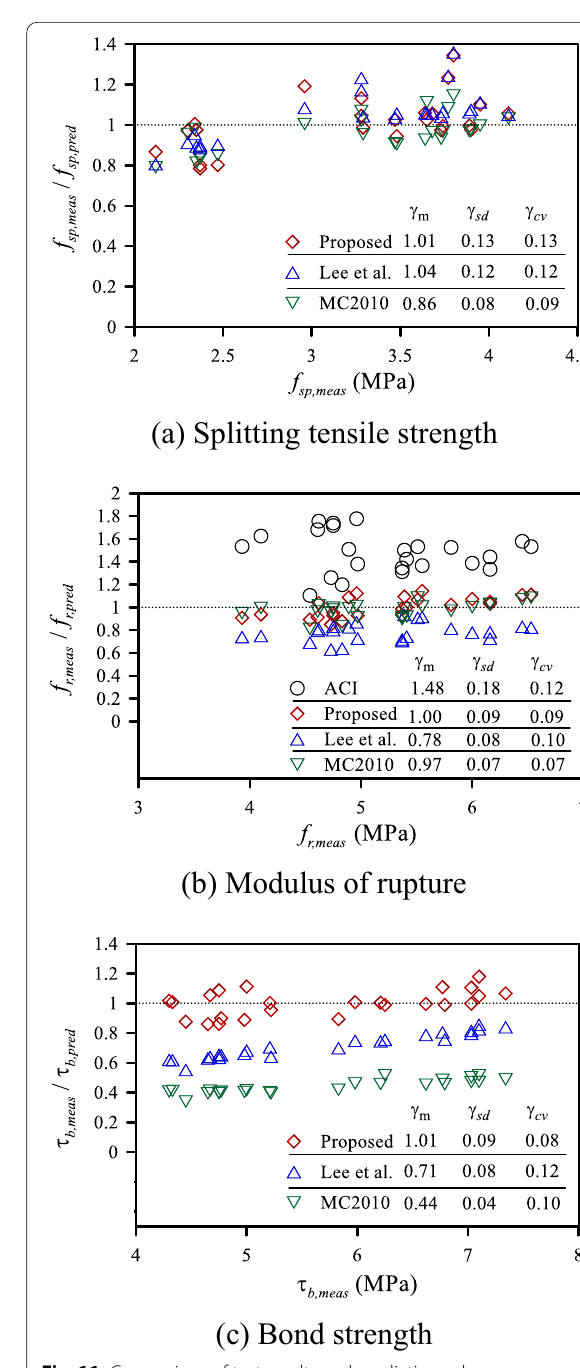
Fig. 10 Effects of f’ c,pred ρ c,pred / ρ 0 on measured mechanical properties and regression analysis.